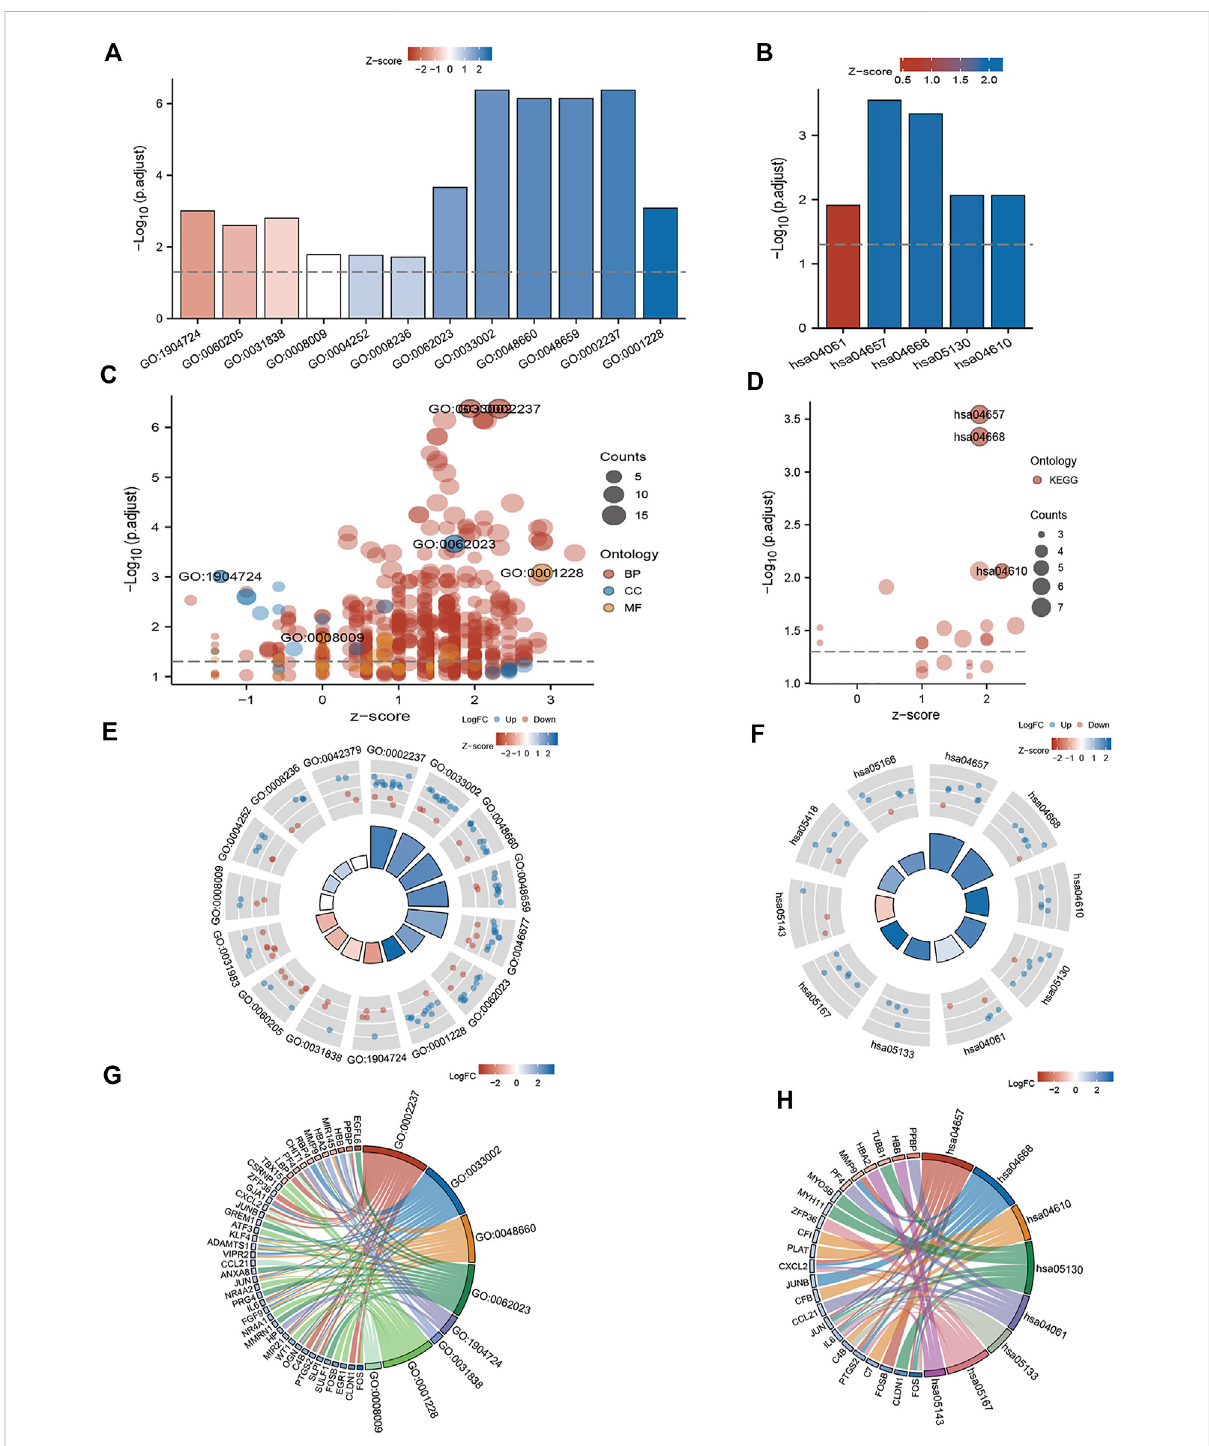
FIGURE 7 GO and KEGG enrichment analyses of DEGs between mitochondrial dysfunction-related clusters A and B. (A,B) Histogram, (C,D) bubble plot, (E,F) circle plot, and (G,H) chord diagram of the results of GO and KEGG enrichment